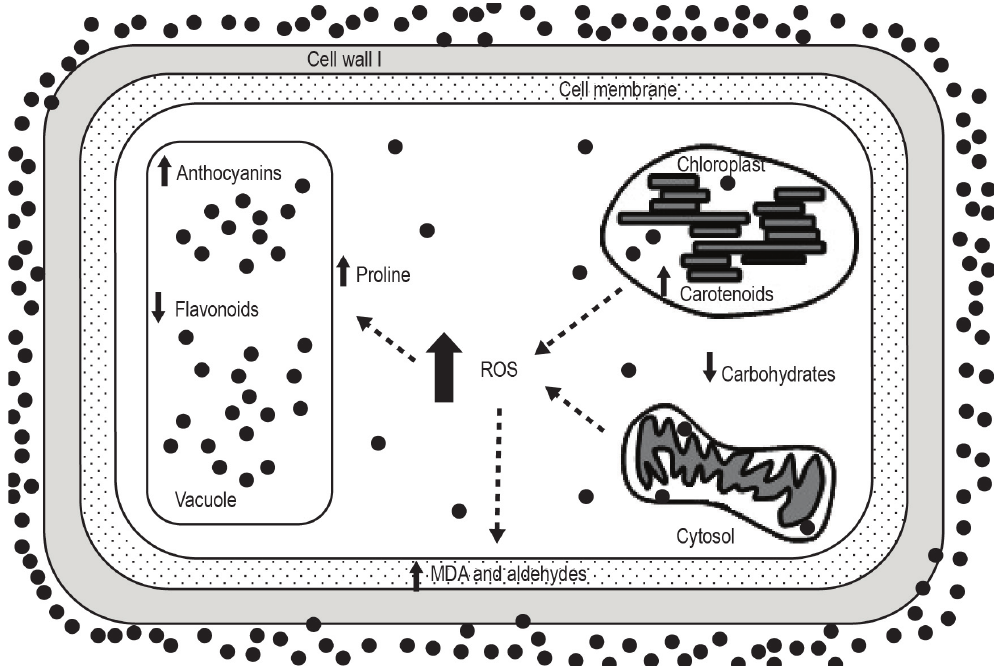
Figure 4. Physiological responses of Salvinia auriculata Aubl. to the addition of Cu ( ● ). Chloroplast and mitochondria are compartments that produce reactive oxygen species (ROS) continuously. With the increase in the concentration of Cu in the intracellular environment, disorders occur in these organelles, which increase the production of ROS and affect the synthesis of carbohydrates and flavonoids. This makes the plant cell import Cu for the vacuole, which is rich in ROS, activating non-enzymatic systems in this organelle (production of anthocyanins and flavonoids) as well as chelators in the cytosol (proline). Carotenoids reduce ROS in the chloroplasts and the anthocyanins act similarly in the vacuole. Added to this, the excess Cu and ROS affect biological membranes through the degradation of fatty acids causing lipid peroxidation, and consequently the production of the malondialdehyde (MDA) and others